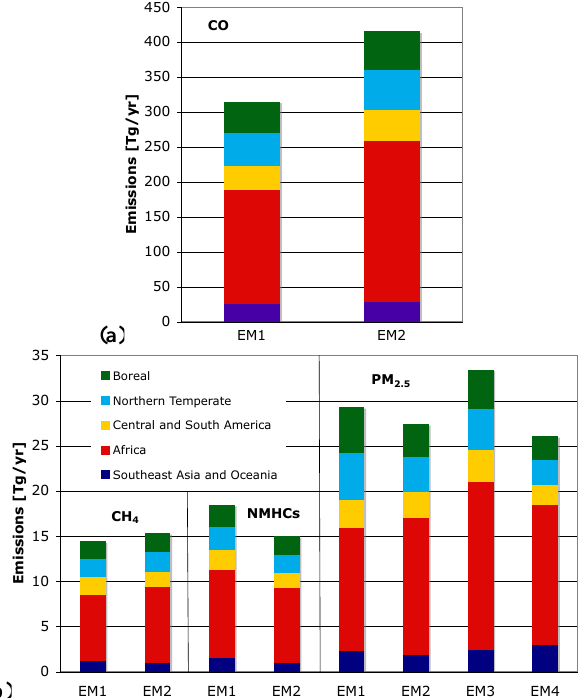
Fig. 5. Average emissions 1997–2009 region of (a) CO; and of (b) methane, non-methane hydrocarbons (NMHCs) and aerosol par- ticulate matter up to 2.5 microns. Emissions are for c w = 0 . 2 and different emission model (EM). Boreal: Boreal North America and Boreal Asia. Northern Temperate: Temperate North America, Eu- rope, Middle East and Central Asia. Southeast Asia and Oceania: Southeast Asia, Equatorial Asia and Australia and New Zealand.